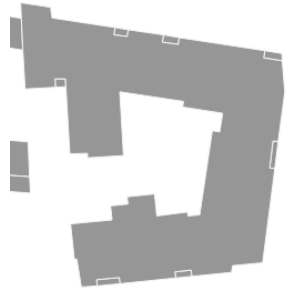
Figure 1. A French building mapped on OSM in eight